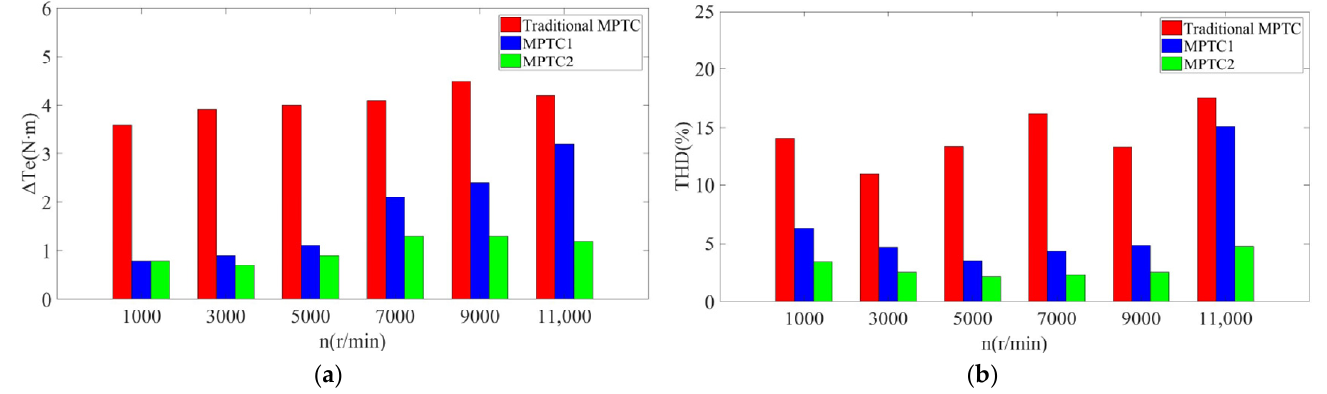
Figure 20. Performance comparisons under the load of 2.2 N·m in the full speed range: ( a ) quantitative comparisons of torque ripple; ( b ) THD comparisons.